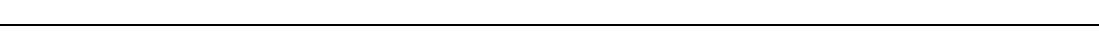
Fig. 7 Progesterone regulatory network is impaired in R330fs mutant cells. a Clustered heatmap showing the differential gene expression (DEG) by progesterone (150 nM, 3 h) treatment in T47D and CR3 cells. The genes are fi rst grouped by DEG status (upregulation and downregulation are indicated as red and blue arrows respectively), then sorted by decreasing FPKM within each group. b Upregulated and downregulated genes in T47D cells and CR3 cells after progesterone treatment. Venn diagram represent the overlap between differentially expressed genes in T47D cells and CR3 cells. c Representative genome browser tracks at differential PR-binding sites. UCSC Genome Browser views showing the mapped read coverage of PR ChIP-seq. d Differential- binding analysis of PR-binding events in control T47D versus CR3 cells. Increased, decreased, and unchanged binding events are indicated in red, blue, and yellow respectively. CPM counts per million. e Box-and-whisker plots displaying the PR and TWIST1 expression levels in GATA3-mutant tumors. Expression data were collected from the luminal A and luminal B tumors in each GATA3 status category (the METABRIC cohort). Whiskers indicate 10th and 90th percentiles. Means and medians are shown as plus signs and black lines, respectively. * p < 0.05, ** p < 0.01, *** p < 0.001, **** p < 0.0001, Mann – Whitney test. f – g The oncomine concept analyses. 437 uniquely upregulated genes in progesterone-treated T47D cells were used as the input gene set. q -value: estimated false discovery rates. f Heatmap showing the positive correlation between the uniquely upregulated genes and PR status in the clinical gene expression data. The top 10 genes (ranked by p -values) are shown. g Heatmap showing the underexpression of the uniquely upregulated genes in the aggressive tumors (patients died at 3 years). The top 10 genes are